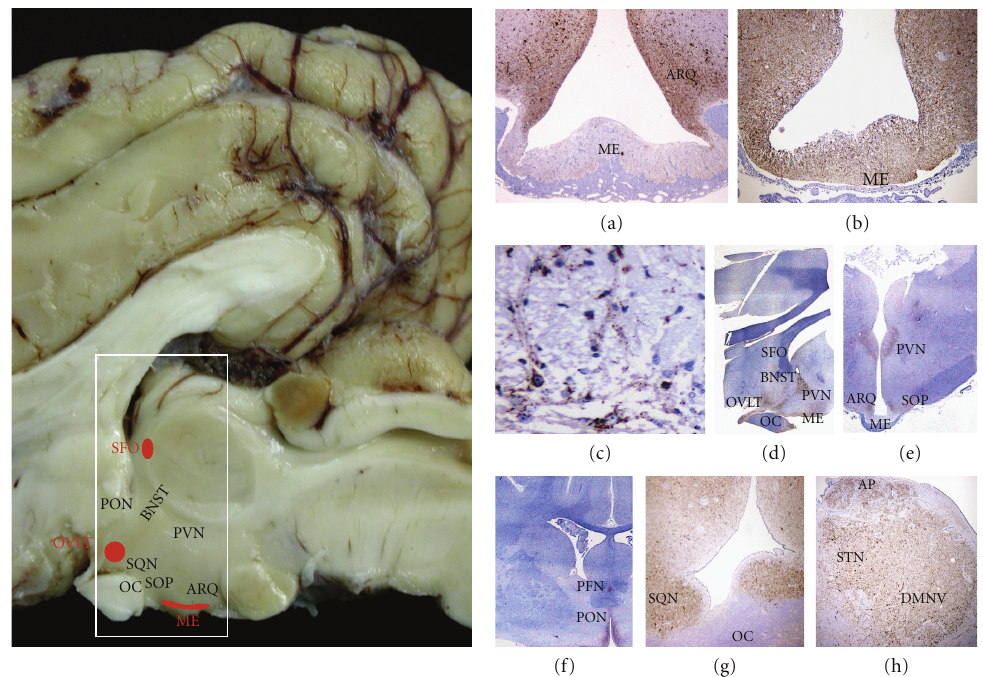
Figure 6: CVO involvement may contribute to the spread of infection into the brain parenchyma . Preclinically a ff ected TSE sheep show mild early PrP d accumulation in the median eminence (ME) (a; x4), or severe deposition in later stages (b; x4). Higher magnification is needed to detect mild PrP d accumulation in the ME (c; x60). In later stages, preclinical sheep do show accumulation of PrP d in those brain areas with established connections with the CVOs. A sagittal section of the diencephalon (d; x1) has been produced from the area compressed in the white rectangle in the macroscopic sagittal view of the brain highlighting some of the neural structures. Thus, the involvement of the ME correlates with PrP d accumulation in the arcuate nucleus (ARQ) (a,b,e), and that of the organum vasculosum of the lamina terminalis (OVLT) and the subfornical organ (SFO) correlates with PrP d in several nuclei: preoptic (PON) (f, x1), suprachiasmatic (SQN) (g; x4), supraoptic (SOP) (e, x1), paraventricular (PVN) (d,e), bed nucleus of the stria terminalis (BNST) (d) and perifornical (PFN) (f). Such correlations are di ffi cult in the vagal complex because of the widespread severe PrP d accumulation (h).